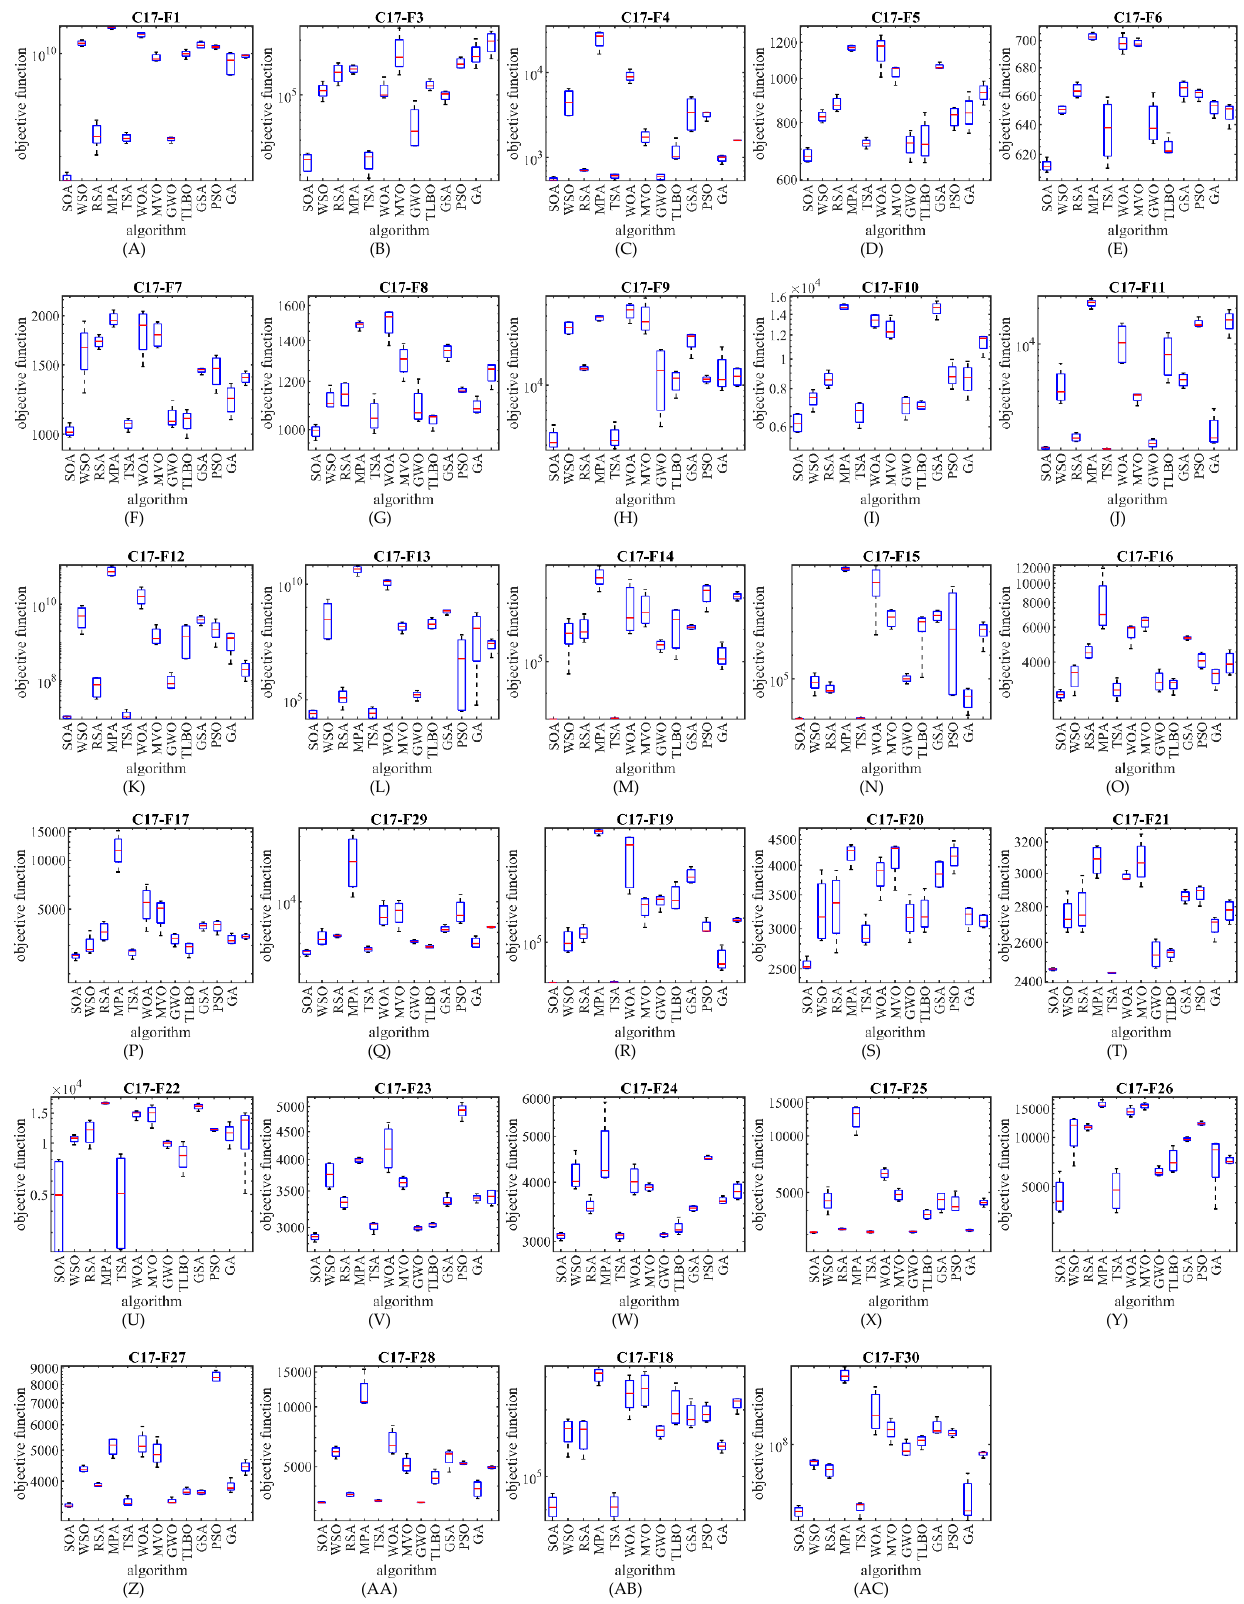
Figure 4. Boxplot diagram of SOA and competitor algorithms performances on the CEC 2017 test suite (for the dimension 𝑑 = 50 ).